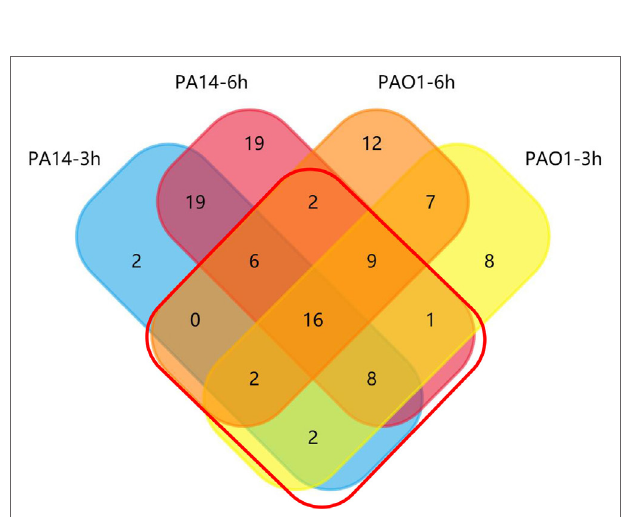
FigUre 1 | Expression levels of the outer membrane proteins relative to RpsL (ribosomal protein, serves as the internal control). The heatmap analysis was performed to illustrate the expression profile of the 158 outer membrane protein genes of PAO1 and PA14. The values are log base 10 of the relative expression levels. The black color represents genes undetected in quantitative real-time